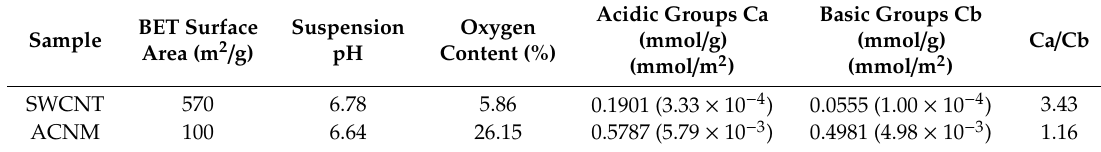
Table 1. Basic physicochemical characteristics of studied